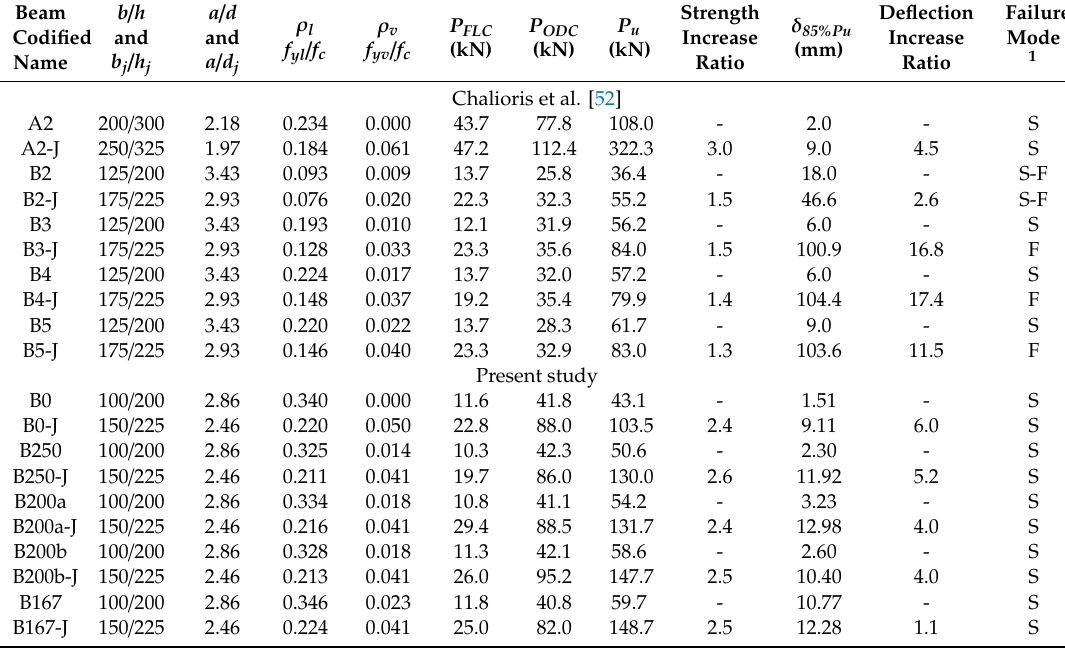
Table 4. Test data of U-jacketed beams from Chalioris et al. [52] and the present